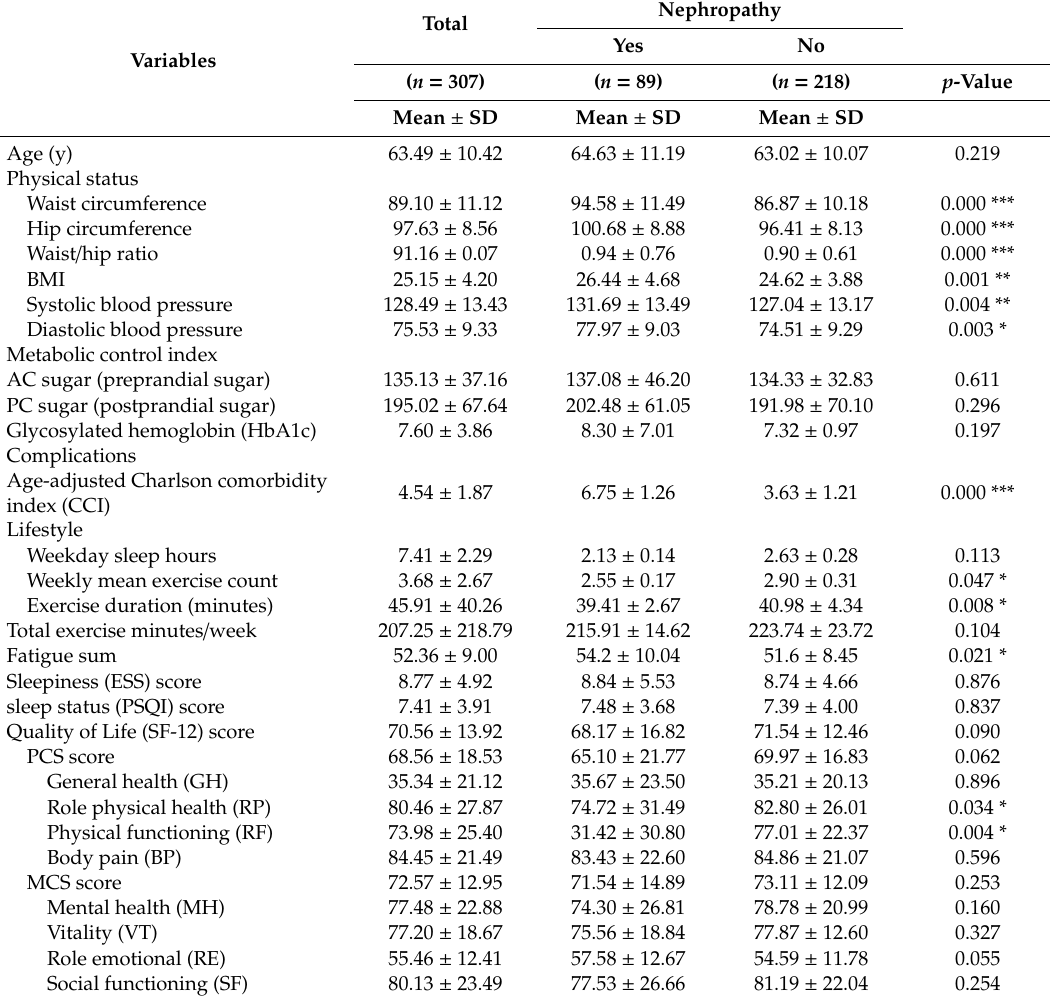
Table 1. Characteristics of the study patients with and without nephropathy ( n =